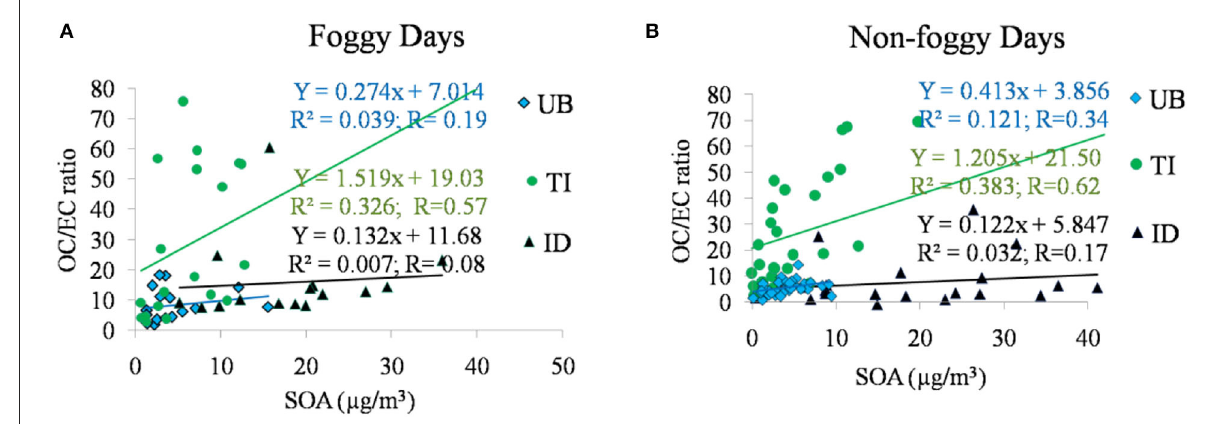
FIGURE3 Relationship of SOA and OC/EC ratio during (A) foggy days and (B) non-foggy days.